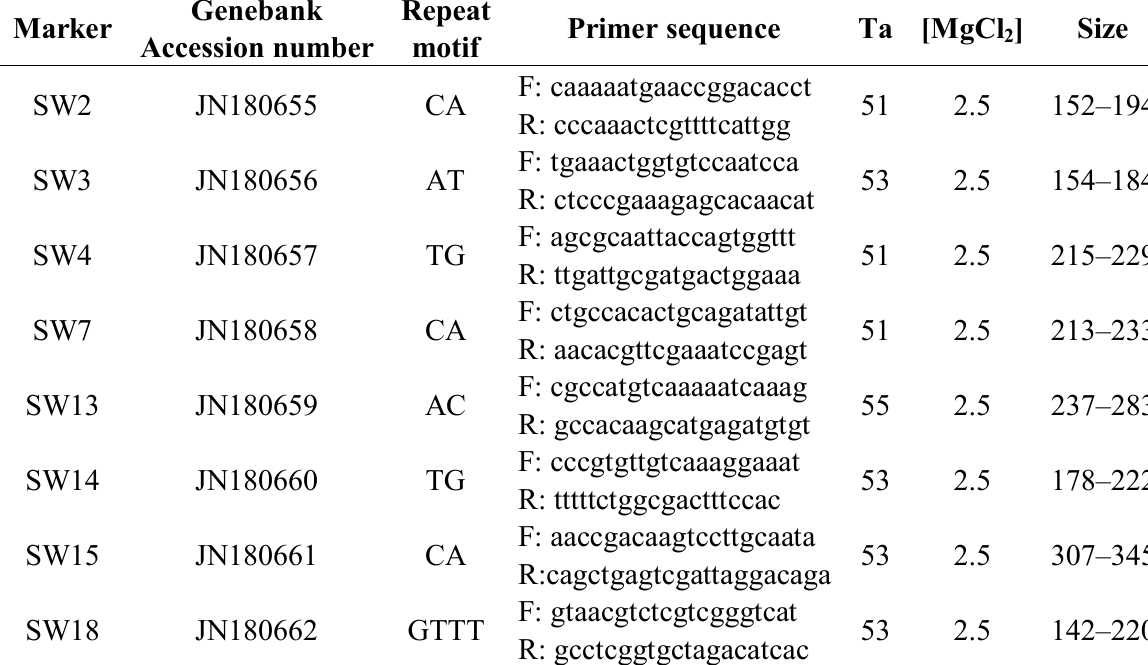
Table 1. Primer sequences and characteristics of eight microsatellite loci successfully amplified in Sinanodonta woodiana . Ta, annealing temperature; [MgCl concentration in the PCR reaction; Size, size range of alleles.